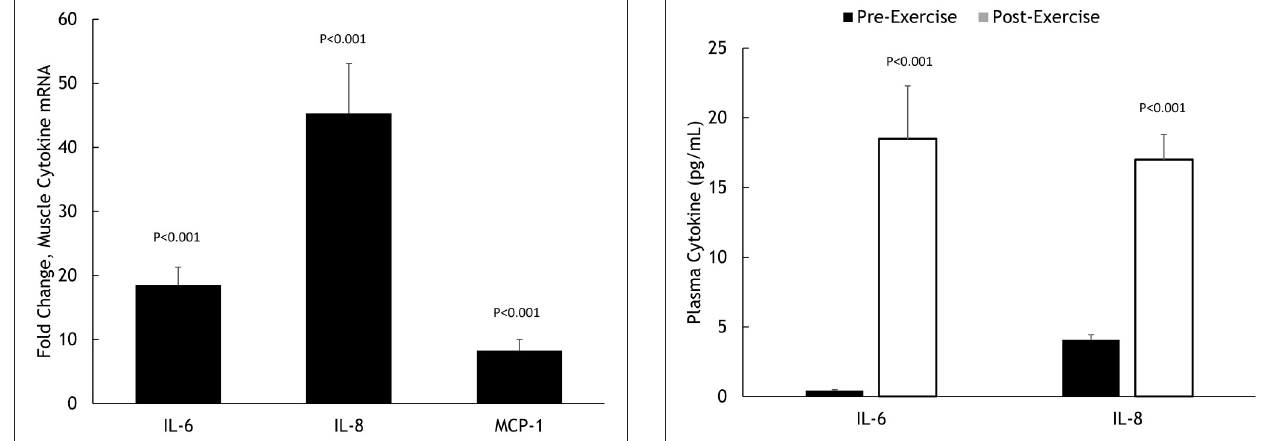
FIGURE 4 | Pre- and post-exercise plasma IL-6 and IL-8 concentrations.